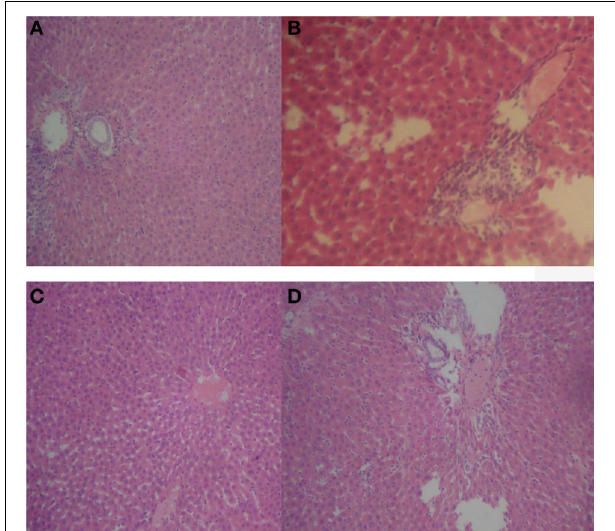
FIGURE 6 | Representative sections of rat kidneys in respect of reversibility study. (A) Normal rat kidney showing regular tubular cells with normal nuclei; (B) 20mg/kg/day HLE-FP-treated rat kidney showing focal area of epithelial cell proliferation; (C) 100mg/kg/day HLE-FP-treated rat kidney showing congested vascular channels and areas of hemorrhage; and (D) 500mg/kg/day HLE-FP-treated rat kidney showing localized hemorrhage and glomerular capillary congestion ( × 100, × 400